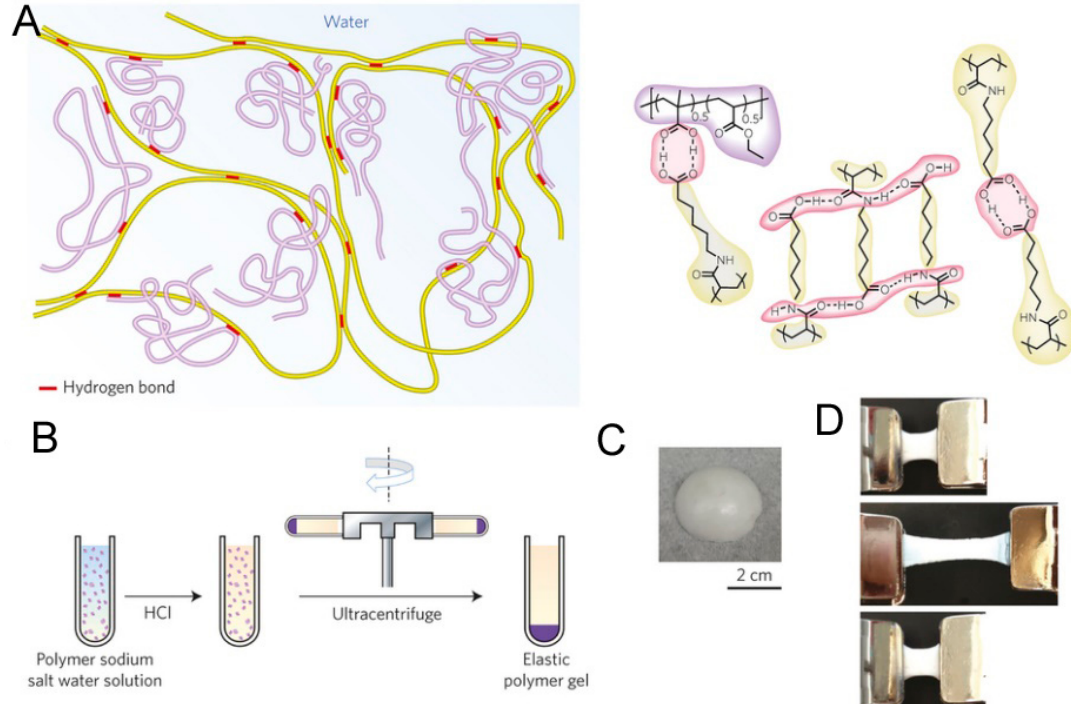
Figure 16. ( A ) Proposed supramolecular polymer gel network. Structures in yellow, synthesized poly(acryloyl 6-aminocaproic acid) (PA6ACA); structures in purple, linear poly(methacrylic acid-co-ethyl acrylate) (EUDRAGIT L 100-55); red part, inter-polymer hydrogen bonds; ( B ) Manufacturing process of the polymer gel. ( Left ), the homogeneous solution of PA6ACA sodium salt solution and L 100-55 sodium salt solution with varying polymer weight ratios. ( Middle ), the addition of HCl solution resulting in precipitation; ( Right ), formation of the elastic polymer gel after ultracentrifugation; ( C ) Photo of a piece of the polymer gel obtained after ultracentrifugation; and ( D ) Images of stretch and recovery testing of a polymer gel with PA6ACA:L 100-55 = 1:2. ( Top ), 1.5 cm piece of polymer gel held between two clamps. ( Middle ), stretching of the polymer gel to three times its initial length; ( Bottom ), recovery of the polymer gel 5 min after the external force was removed. Scale bar is 2 cm for ( C ) and ( D ). Reprinted with permission from [180]. Copyright 2016 Nature Publishing Group.